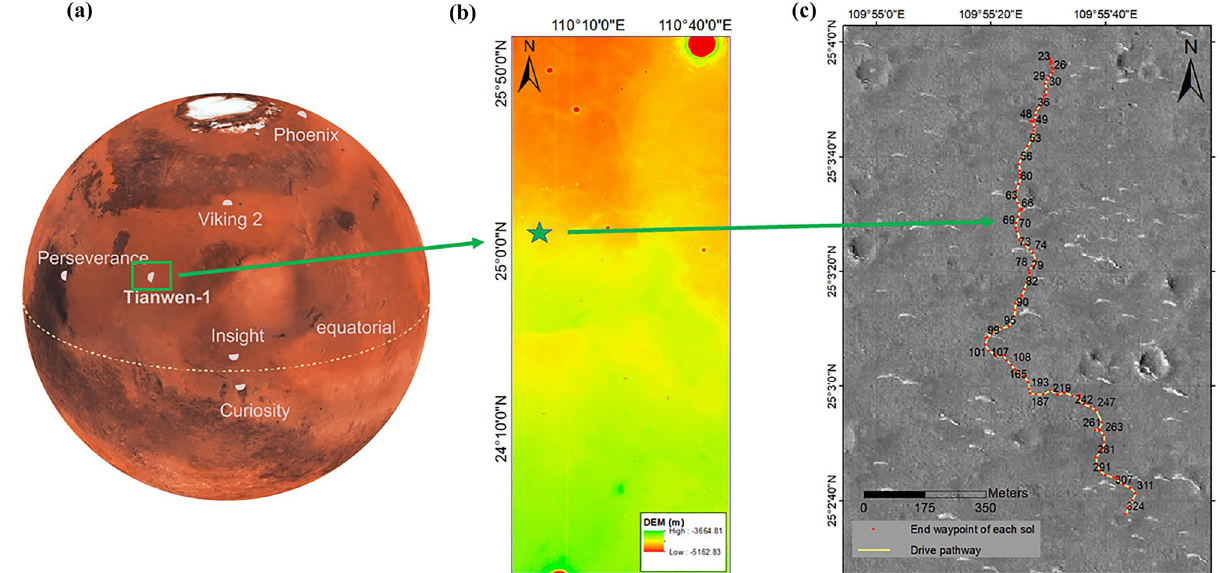
Figure 1. Location of the Tianwen-1’s landing site on Mars, ( a ) along with other landers and rovers operated at the surface of Mars. The south of Utopia Planitia is a place that has not been visited by previous missions. ( b ) Digital elevation map of Utopia Planitia taken by Tianwen-1’s high-resolution imaging camera. ( c ) The drive pathway of the Zhurong rover during its first 325 sols. The red points represent the end waypoint on each